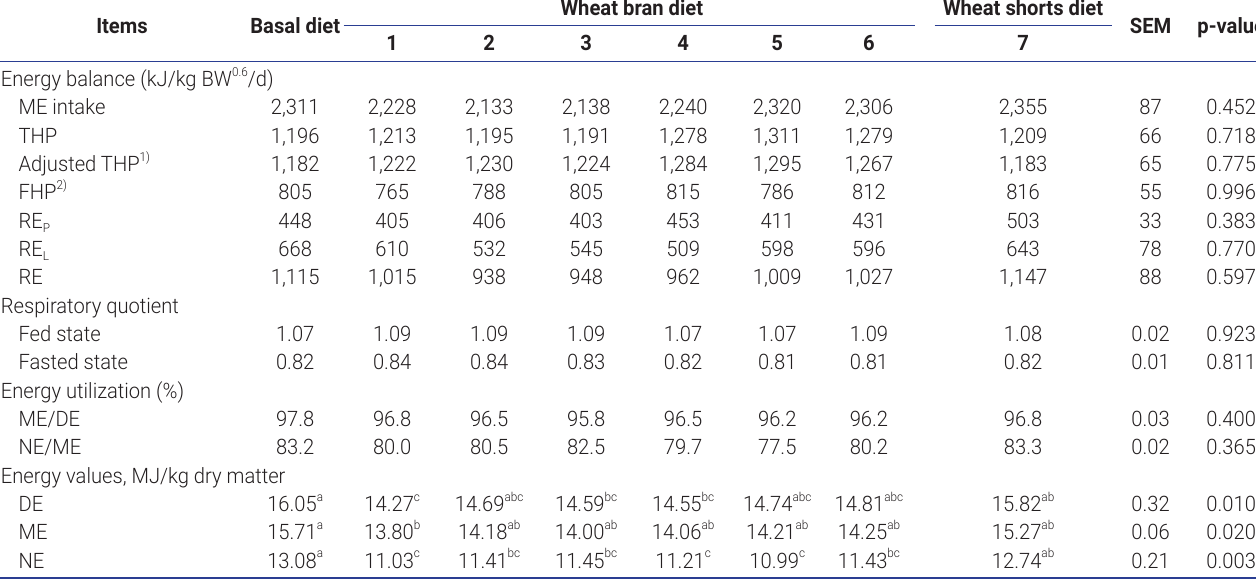
Table 4. Effect of diet characteristics on energy balance and energy values of growing pigs fed experimental diets (n = 6)